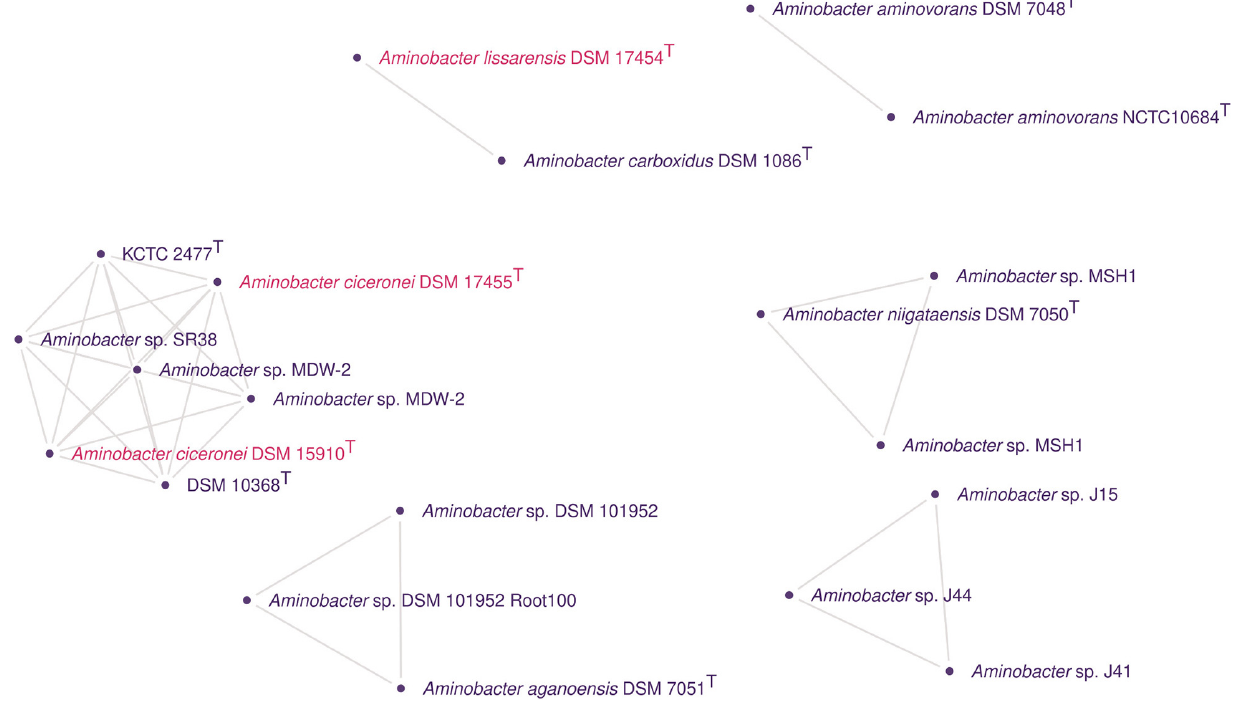
FIGURE 4 | Genomic clusters detected using pairwise ANI values from Aminobacter genomes. In the graph, the clusters have nodes corresponding to genomes and edges corresponding to ANI values above the cut-off for species delineation with a reliable alignment of between the genomes. Isolated nodes were removed. Different colors were used whenever possible to indicate different species